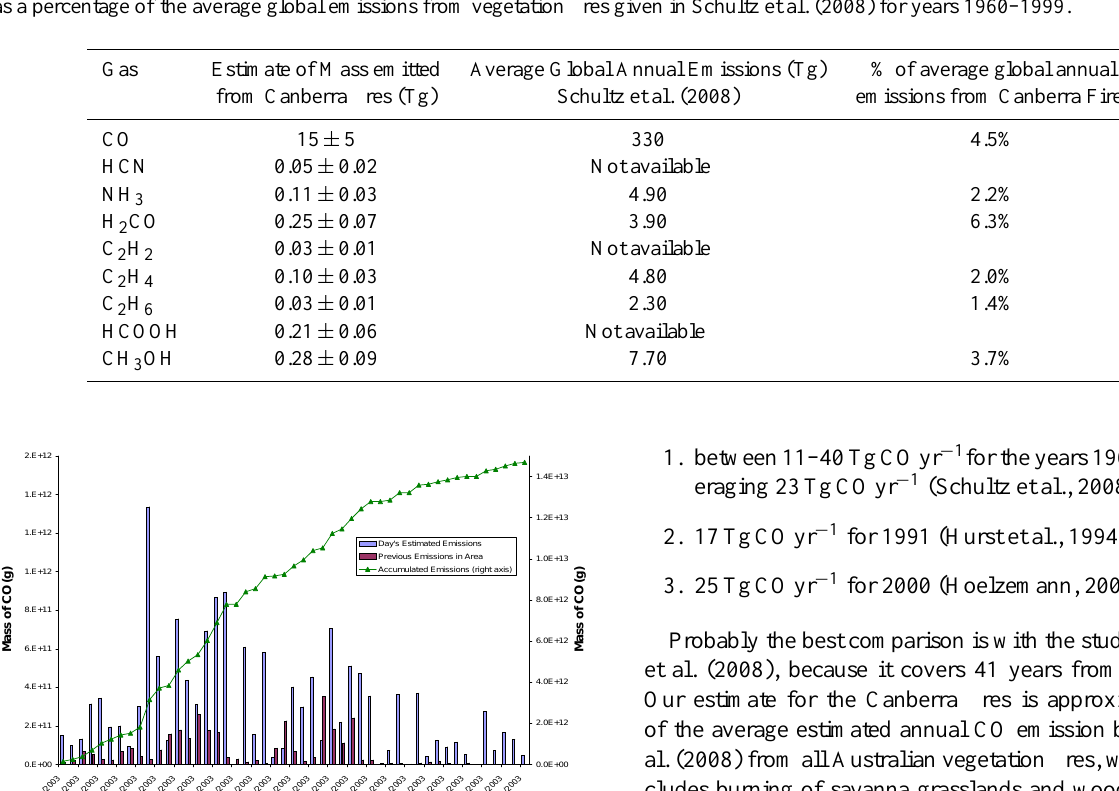
Table 2. Estimated total emissions from this study for the Canberra fires for all of the measured trace gases are shown in Tg and expressed as a percentage of the average global emissions from vegetation fires given in Schultz et al. (2008) for years 1960–1999.